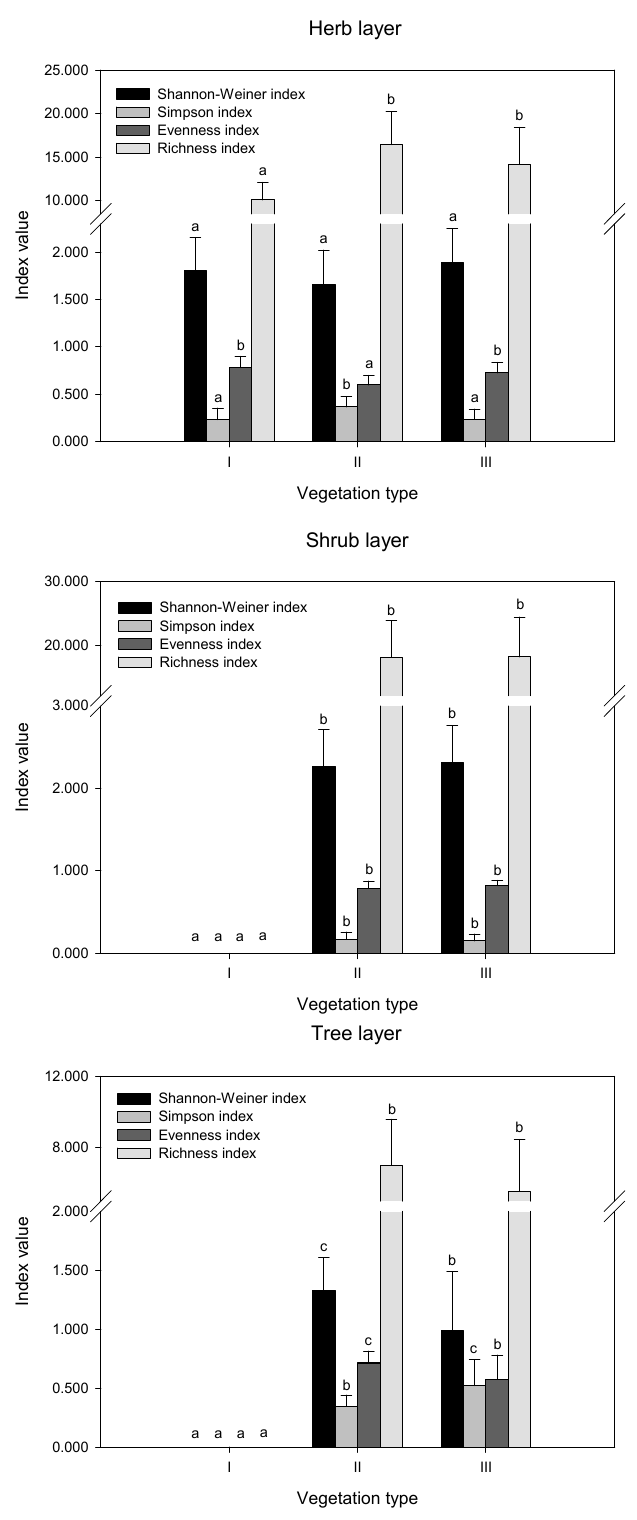
Figure 2. Biodiversity indices in different layers of remnant vegetation. I indicates urban weeds; II indicates secondary coniferous and broad ‐ leaved mixed forest; III indicates secondary broad ‐ leaved forest. Different letters indicate significant differences at the confidence level of p < 0.05 among the vegetation types (one ‐ way ANOVA, p < 0.05).